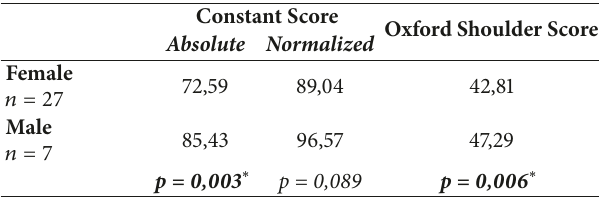
Table 3: Correlation between clinical scores and